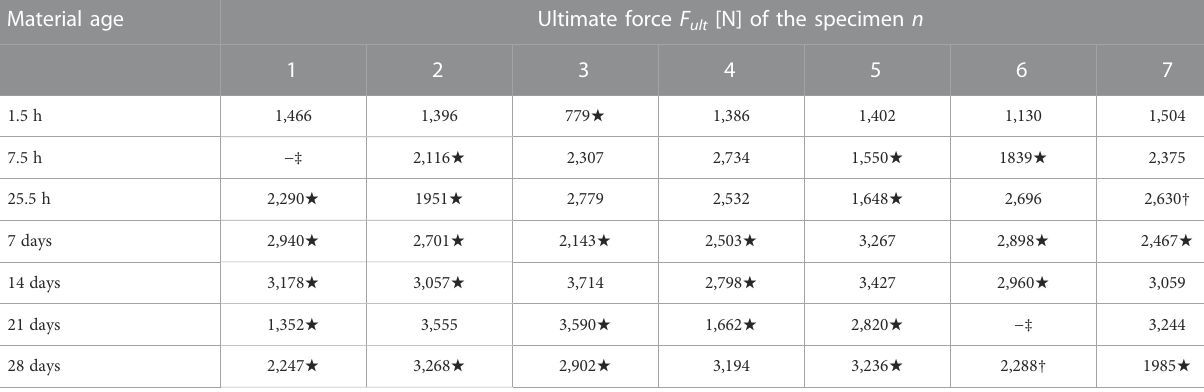
TABLE 3 Values of the compressive ultimate forces sustained by the 4/6 specimens, tested at speci fi c material ages. Material